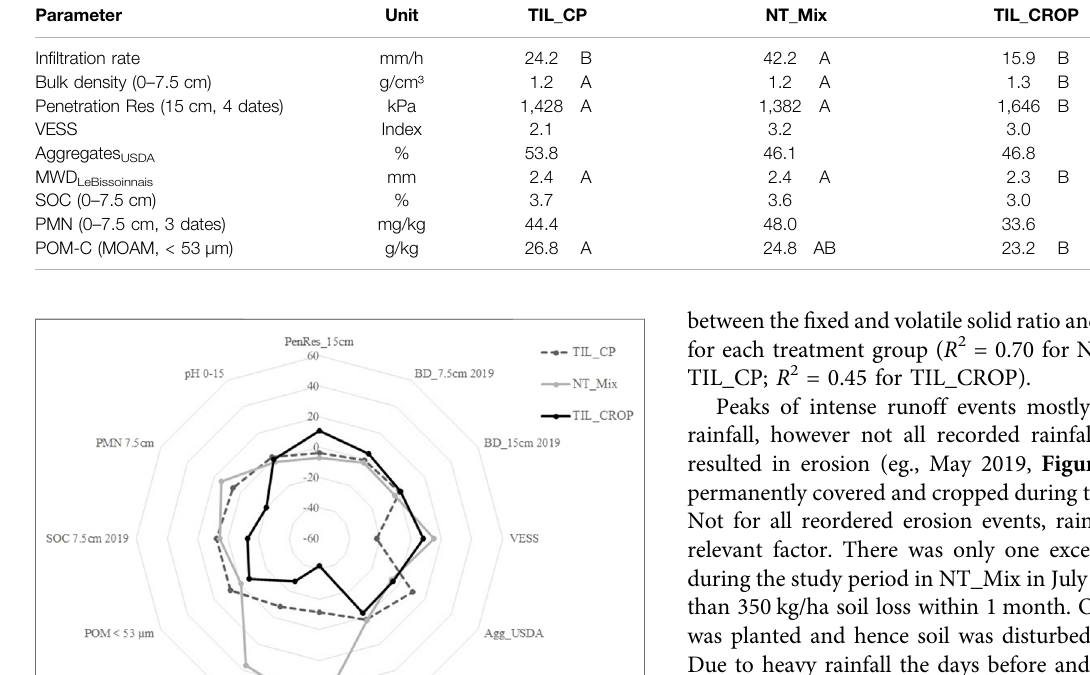
TABLE 4 | Treatment averages for physical and chemical soil properties measured in 2019 (GLM-SAS: capital letters indicate evidence of signi fi cant different treatment groups ( p < 0.05); MWD-mean weight diameter, SOC-soil organic carbon, PMN-potentially mineralizable nitrogen, POM-C-particulate organic matter carbon). Parameter